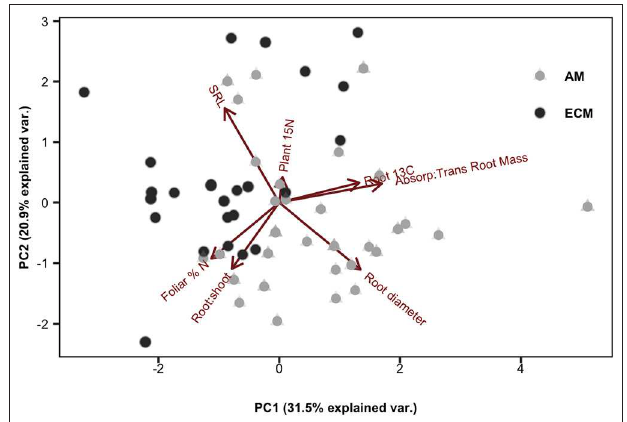
FIGURE 4 | Principal component analysis of individual plant traits including: specific root length (SRL), absorptive root diameter, plant 15 N, absorptive: transport root mass, root 13 C (per unit 13 C fixed), root: shoot mass, and foliar %